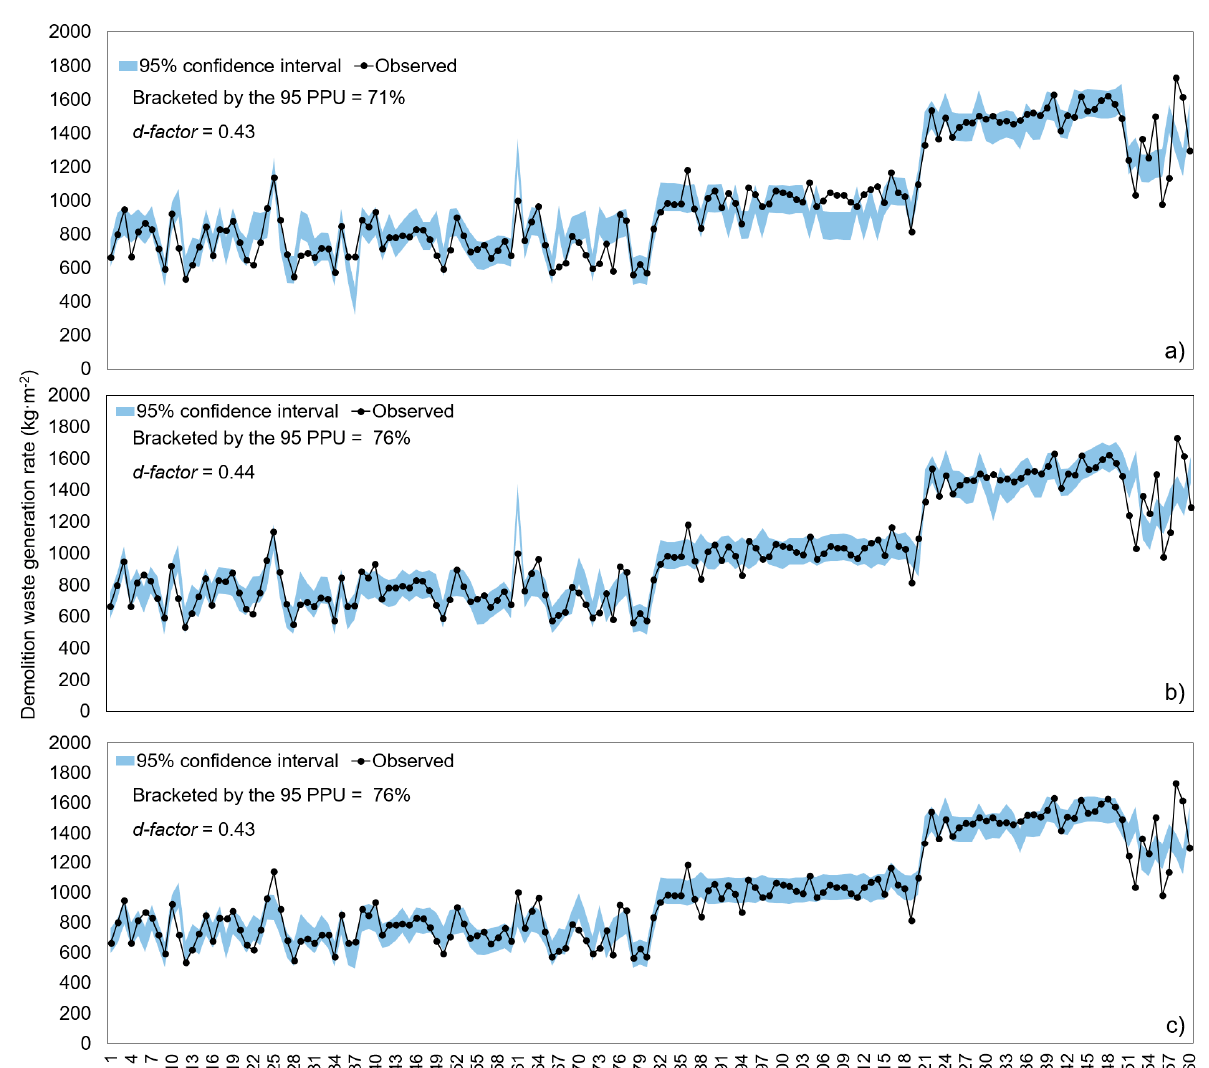
Figure 6. Observed and 95% confidence intervals for estimates of DWGR by ( a ) ANN − ReLu, ( b ) SVM − polynomial, and ( c ) ANN − Logistic.